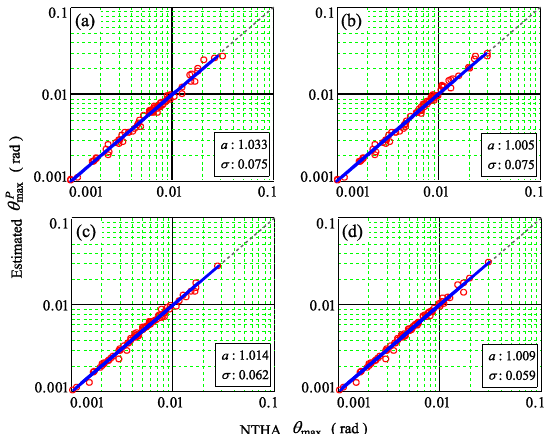
Figure 7. Regressions of θ max on θ P max for a twelve-story frame with dampers: ( a ) κ = 1.5 and υ = 0.4; ( b ) κ = 1.5 and υ = 0.6; ( c ) κ = 3 and υ = 0.4; and ( d ) κ = 3 and υ = 0.6.